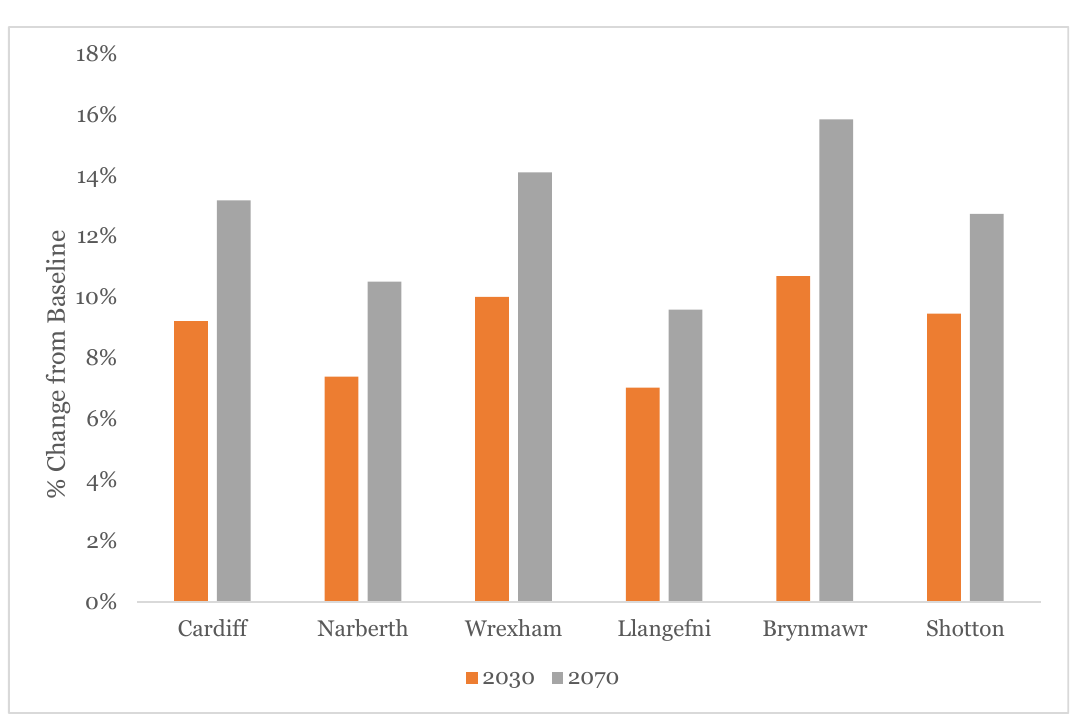
Figure 4. Change in average daily solar flux for 2030 and 2070. Brynmawr is projected to see the greatest increase in average daily solar flux, with an 11% increase from baseline by 2030 and a 16% increase by 2070. Meanwhile, Llangefni, the location with the least pronounced increase, is still projected to experience a 7% in- crease from baseline by 2030 and a 10% increase from baseline by 2070. Across all six locations the daily average relative humidity is highest in the winter months and lowest in the summer months. This is demonstrated for Cardiff in Figure 5.